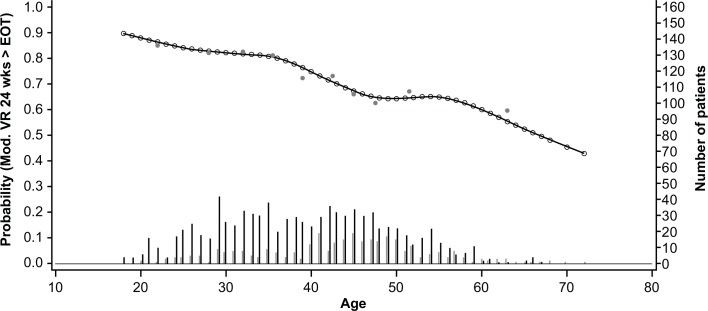
Relationship between age and sustained virologic response (SVR).Short vertical lines indicate the number of patients with SVR (black lines) and no SVR (grey lines). Open circles represent probability of SVR according to the GAM analysis. Closed circles represent empirical probability for midpoints of deciles.